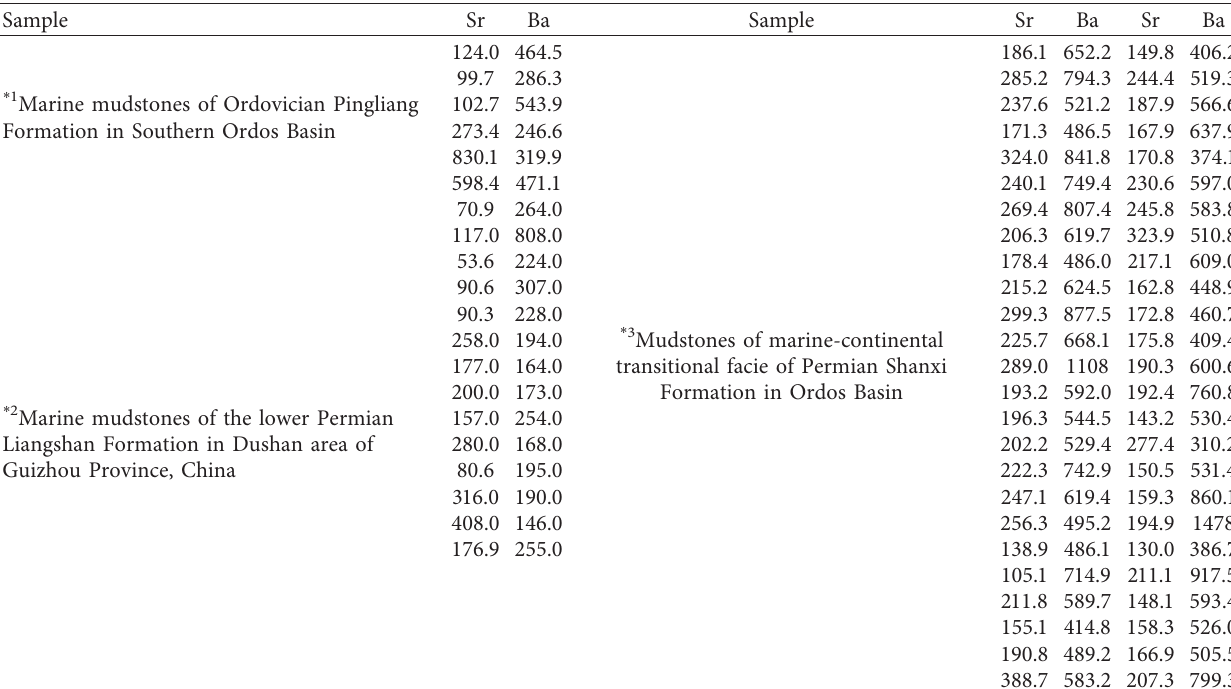
Table 4: Sr and Ba data of Permian in other areas of China.